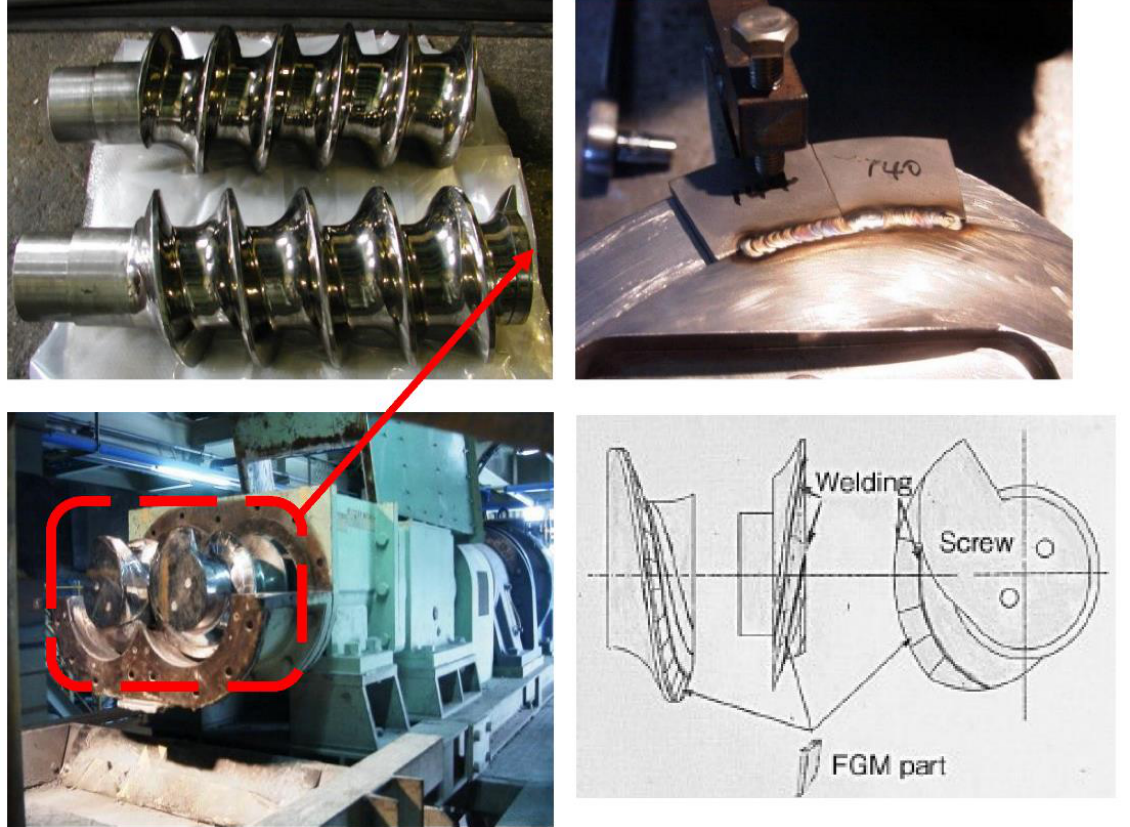
Figure 48. Weldable WC/Ni FGMs tile and the FGMs screw product for the extruding machine.